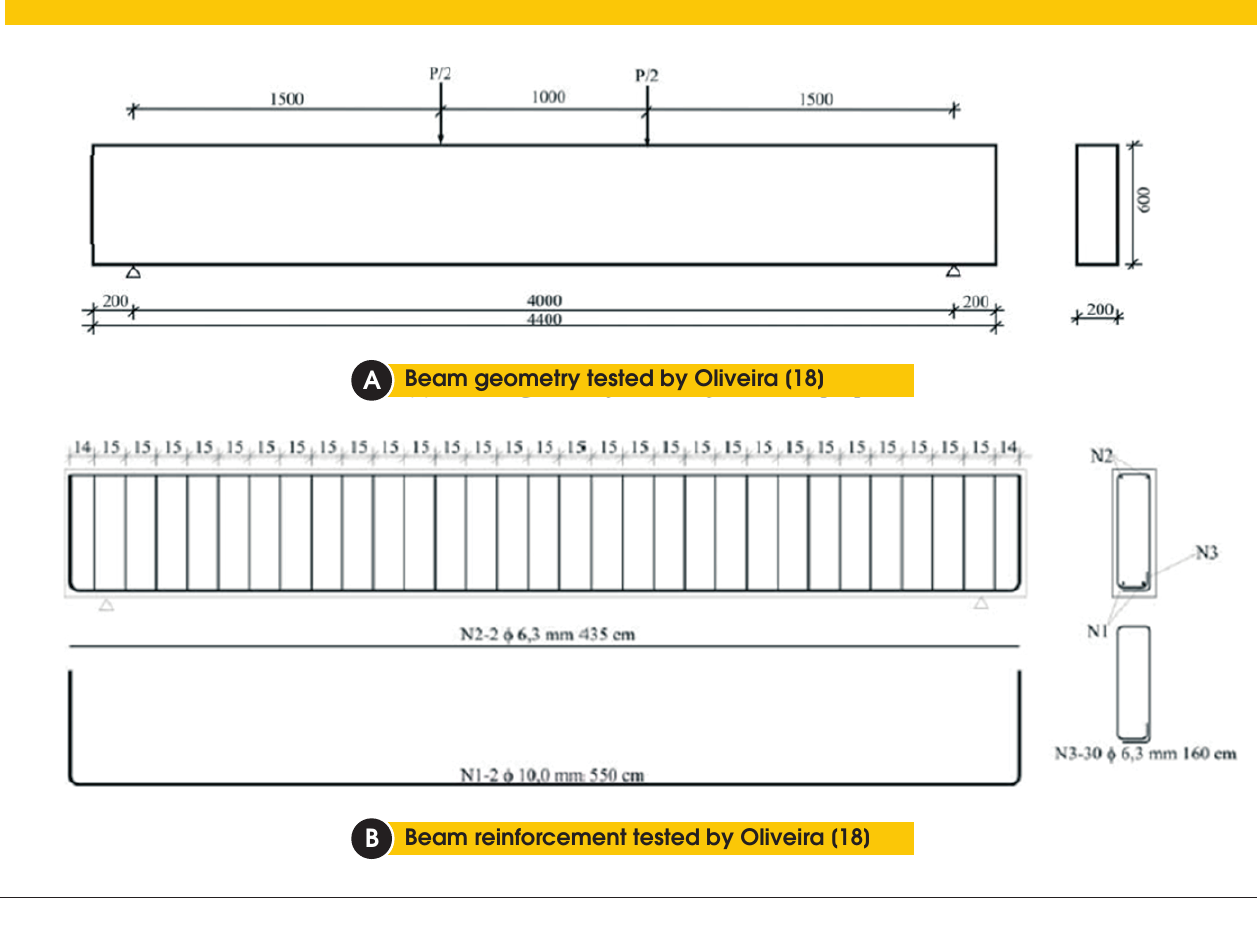
Figure 20 – Numerical and experimental curves of beam V7 of Oliveira [17]